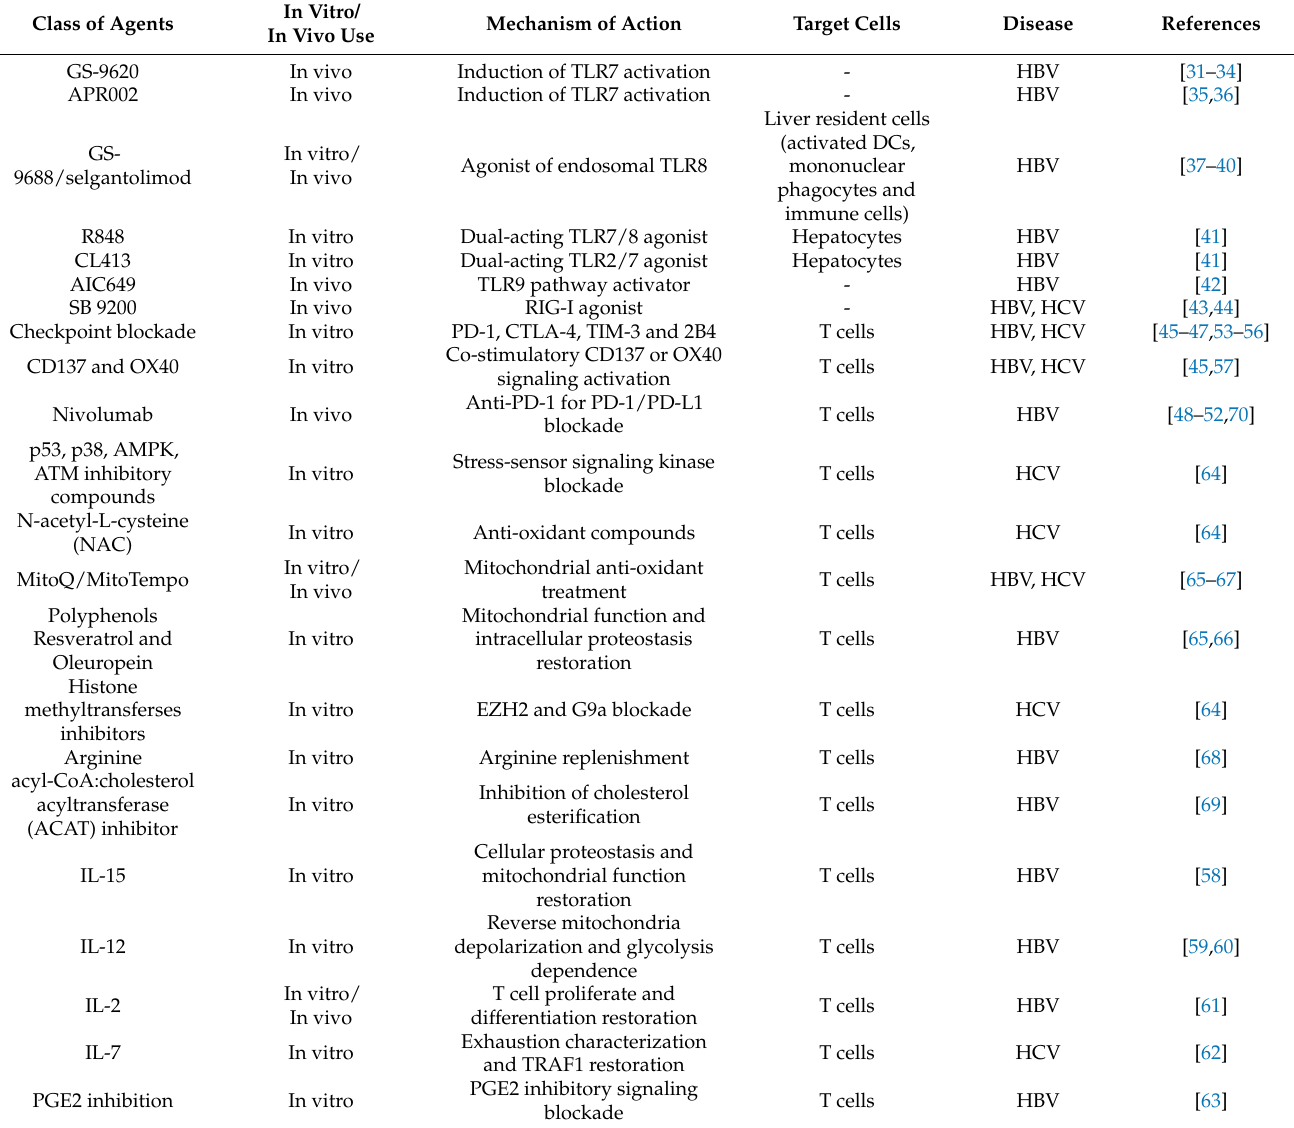
Table 2. Combination Therapies based on immune-modulation for T cell